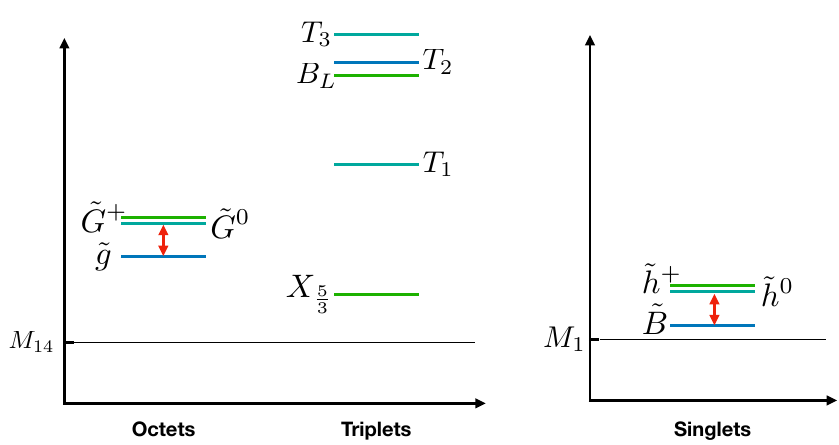
Figure 3. Template spectrum of the chimera baryon states, where T 1 , 2 , 3 are the mass eigenstates with the same charge as the top quark. Together with B , they receive a positive mass shift due to L the mixing with the top. The mass splitting highlighted by the red arrow also receives significant contribution from the different masses in the ψ